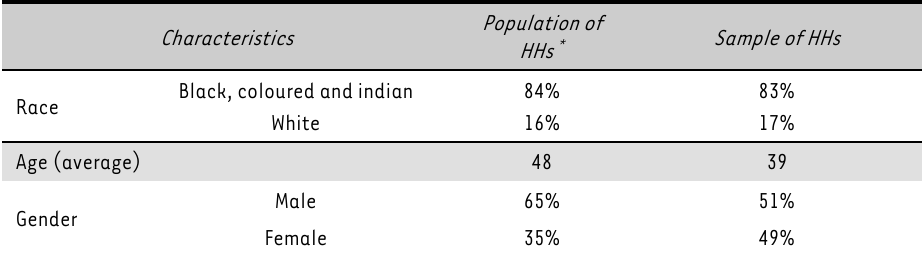
Population of Sample of HHs HHs *